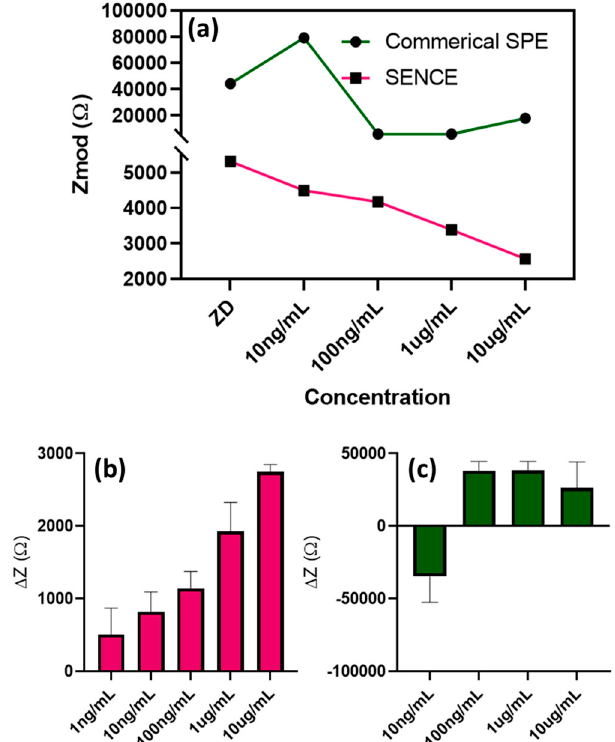
Figure 5. ( a ) Comparison plot of impedance responses at 10 Hz between SENCE platform (this work) and a commercially available screen-printed electrode (SPE). ( b ) Calibration dose response of CRP in synthetic sweat (pH 6) represented as the change in impedance from baseline in the SENCE platform. ( c ) Calibration dose response of CRP in synthetic sweat (pH 6) represented as the change in impedance from baseline in the commercial SPE.